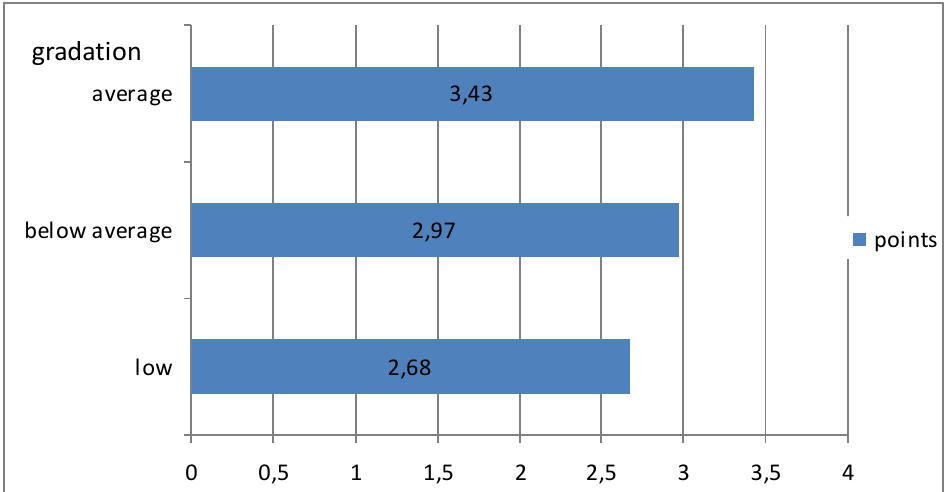
Fig. 2 . Integrated criterion of physical fitness level of females with different gradation of body mass parameter